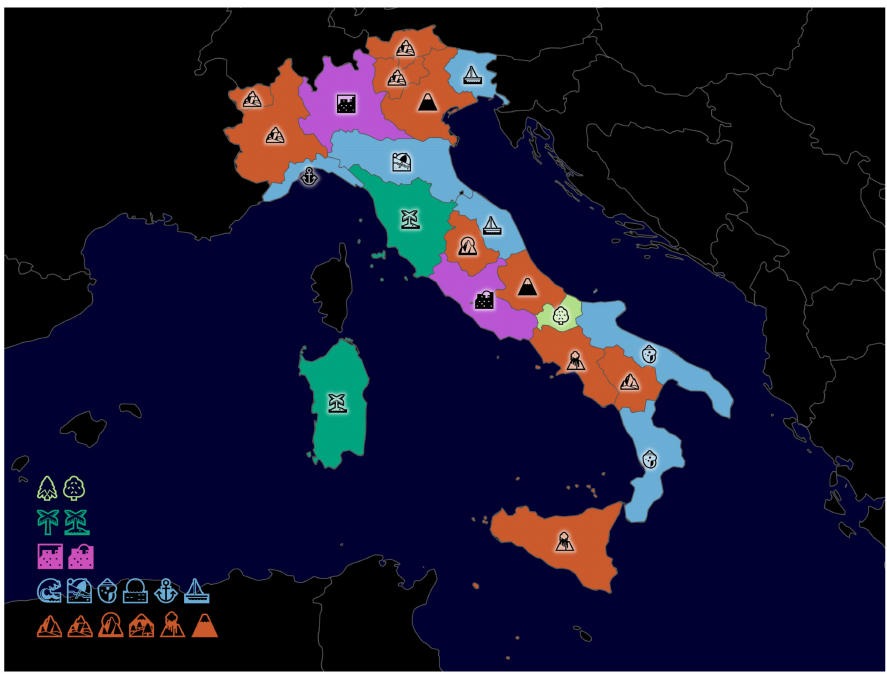
Figure 12. Italian regions with location-specific emojis calculated as typical and color-coded by environmental